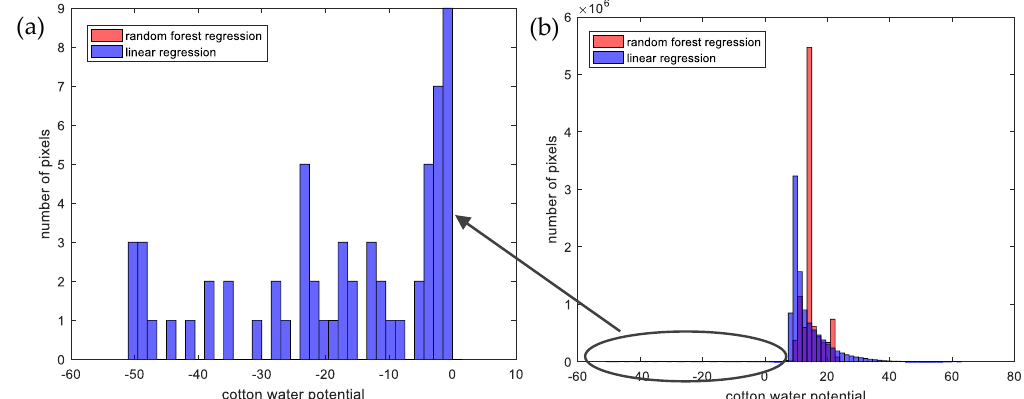
Figure 9. Histogram of cotton water potential and its partial enlarged view on August 6, 2018. ( a ) A partial enlarged view of the histogram; ( b ) histograms of cotton water potential estimated by random forest regression and linear regression.